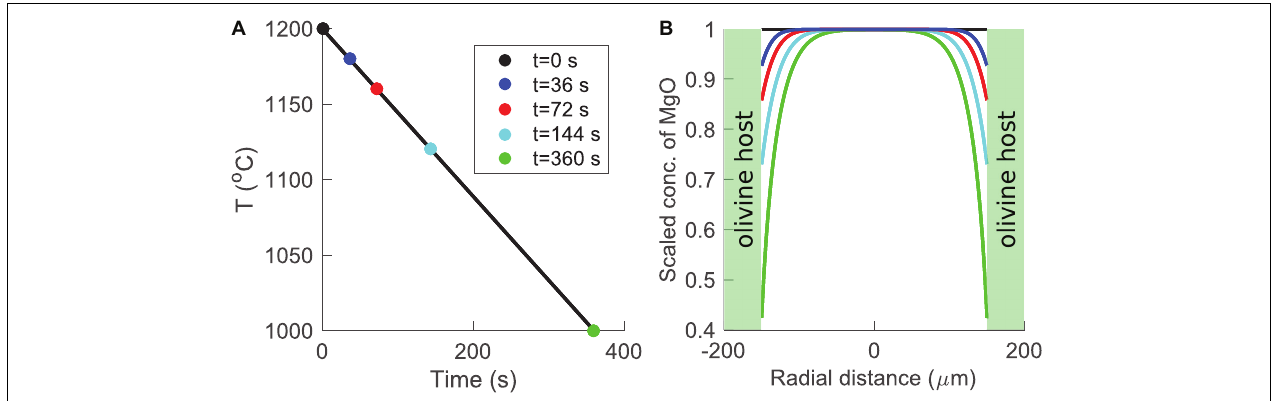
FIGURE 1 | Forward model of the generation of MgO zonation in an olivine-hosted melt inclusion subjected to cooling from 1200 to 1000 ◦ C at a rate of 0.6 ◦ C/s (based on Figure 7 of Newcombe et al., 2014). (A) Temperature-time path imposed by the forward model. Colored circles indicate “snapshots” of the thermal history that are plotted in (B) . (B) Development of MgO zonation in a 150- µ m radius melt inclusion in response to the temperature-time path displayed in (A) . The inclusion is assumed to have an initially homogenous composition (black line). As the temperature decreases, the MgO concentration in the melt at the edge of the inclusion evolves according to the temperature-dependent partition coefficient of MgO between melt and olivine (Newcombe et al., 2014). In response to the cooling and crystallization-induced decrease of MgO at the inclusion edges, MgO diffuses from the center to the edges of the inclusion. Blue, red, cyan, and green curves show snapshots of the evolution of MgO zonation in the melt inclusion after 36, 72, 144, and 360 s, respectively. The green shaded regions are olivine. Note that the position of the olivine-melt interface is assumed to be fixed. Mass balance calculations indicate that the width of the olivine growth rim produced during syneruptive cooling is typically ∼ 1% of the radius of the inclusion such that the movement of the olivine-melt boundary can safely be neglected (Newcombe et al., 2014).